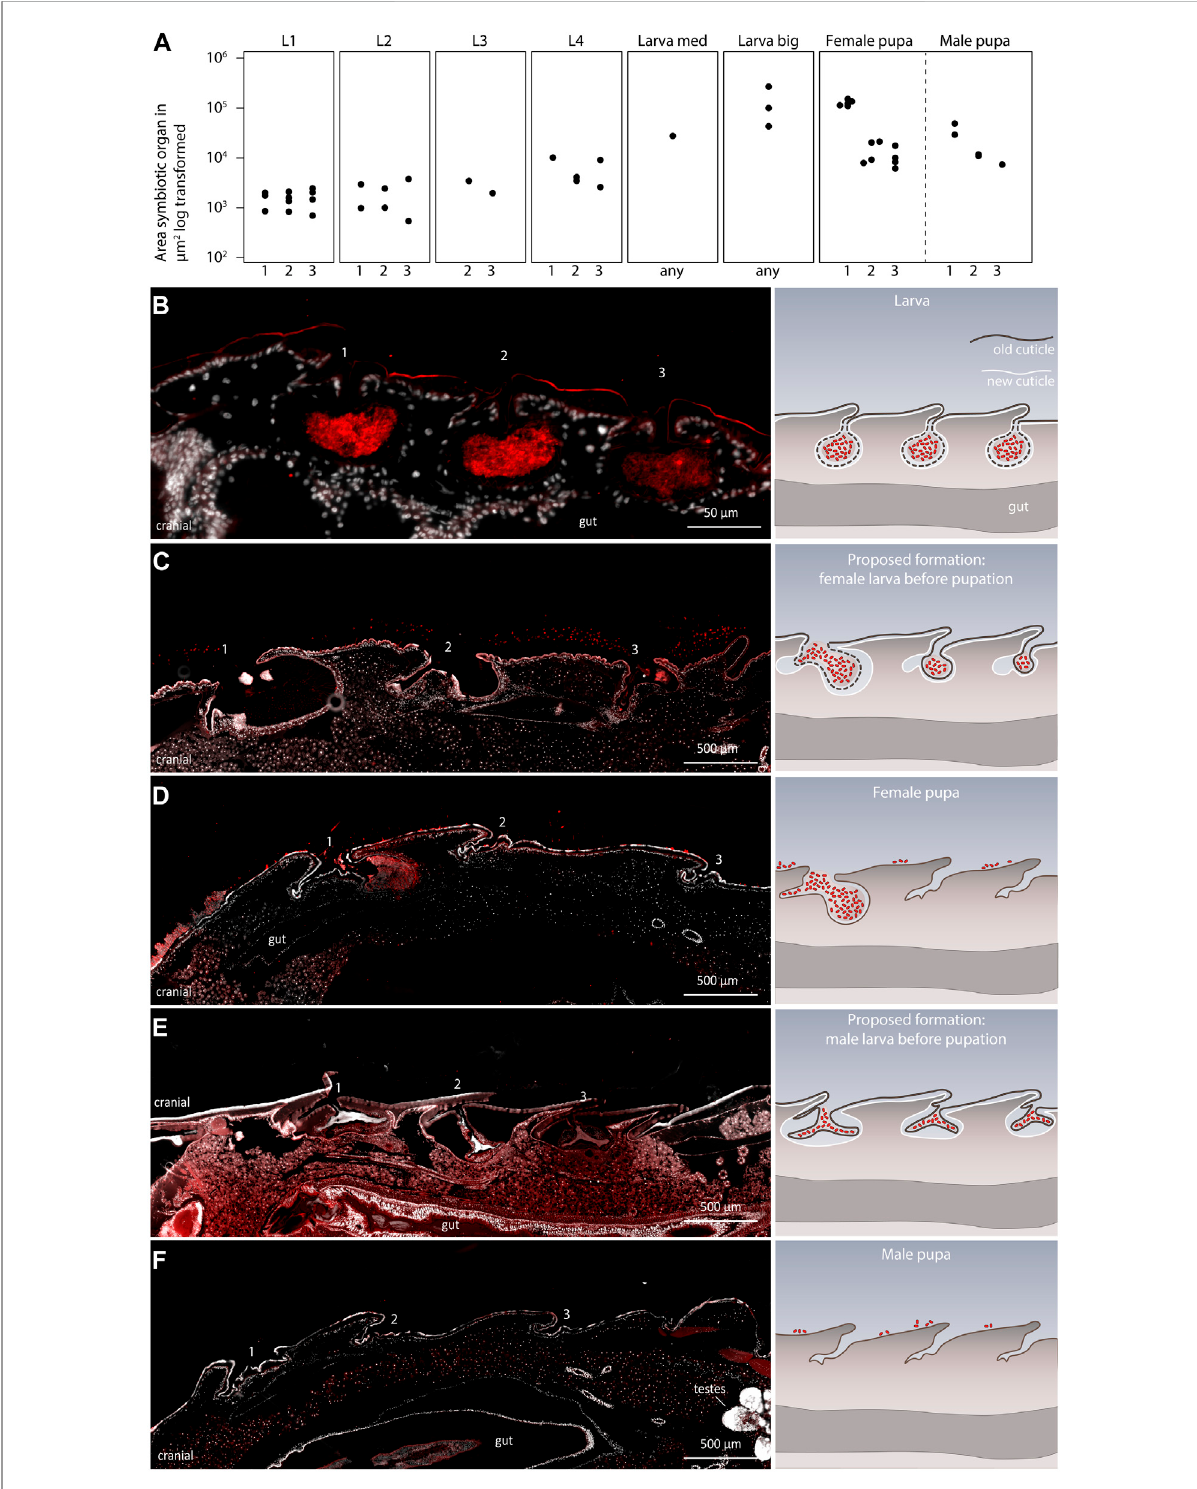
FIGURE 4 Development of the symbiotic organs in late L. villosa larvae and pupae. (A) Size of the symbiotic organs or cuticular structures measured in sagittal sections of L. villosa larvae and pupae. For standardization, sections of individuals which contained the opening canal of the symbiotic organ were chosen. However, variations in exact location, shape, and accuracy during sectioning possibly in fl uenced the measured area. Numbers on the x -axis label refer to the fi rst (1), second (2), third (3) symbiotic organ, or to an unknown (any) symbiotic organ or cuticular structure at the